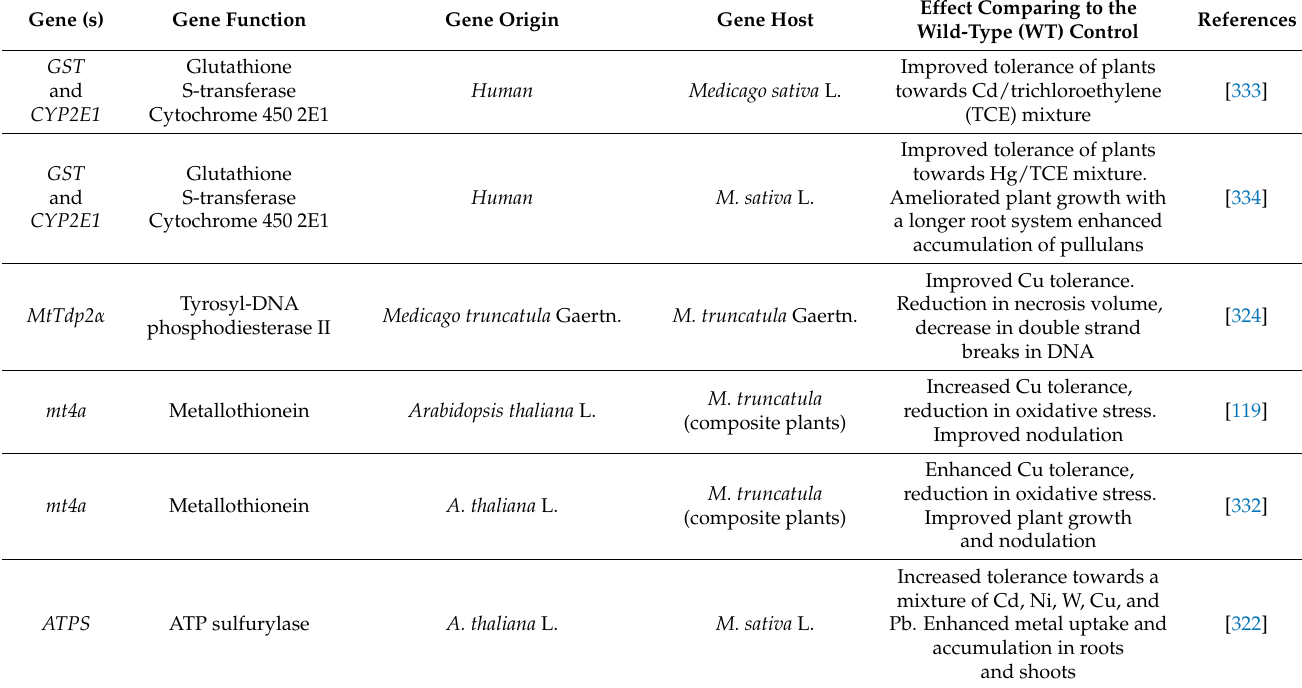
Table 3. Transgenic leguminous plants for improving of a heavy metal phytoremediation